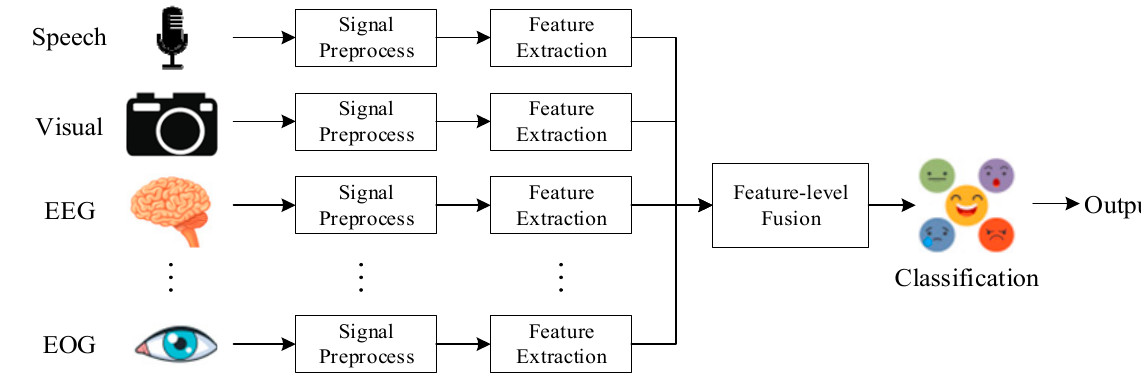
Figure 8. Feature-level fusion.